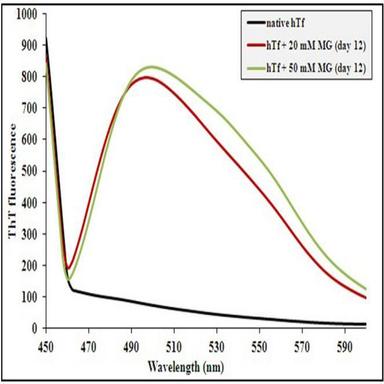
Thioflavin T (ThT) fluorescence. ThT fluorescence emission spectra of hTF in native form and incubated with 20 mM and 50 mM MG for specific time period (day 12). For ThT fluorescence, excitation is carried out at 440 nm while the recording range for the same is 450–600 nm.